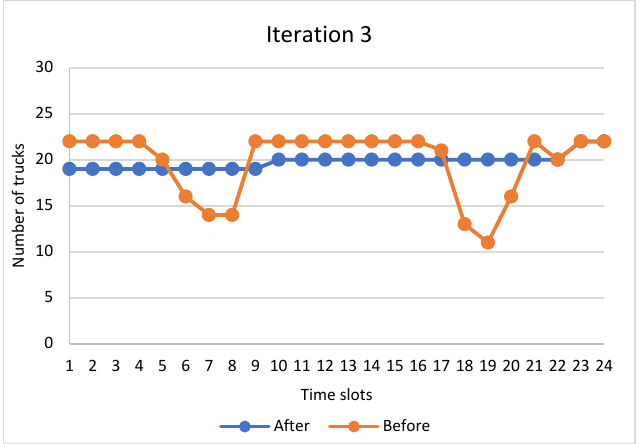
Figure 9. The workload before and after using balancing constraint on iteration 3.